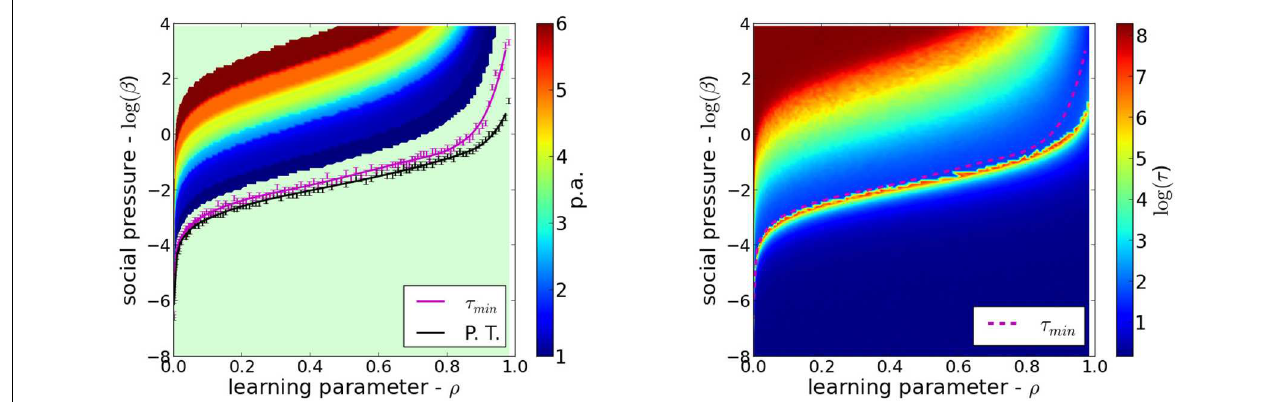
FIGURE 4 | Phase diagram and relaxation times. Left : The phase diagram in the space ρ , a measure of the complexity of socialization vs. the pressure β . The stripes represent regions of the space of parameters where agents could be statistically identified with a group with a given political affiliation. The lower line represents the boundary between order (above) and disordered (below) societies. Below the transition line, and for very large β , no identification with MFT questionnaire respondents was